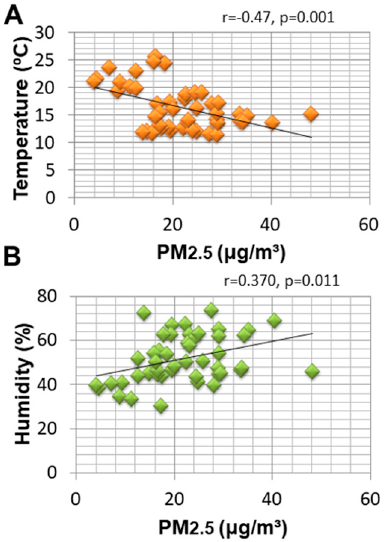
Figure 6. Correlations between meteorological variables and PM 2.5 air pollution.